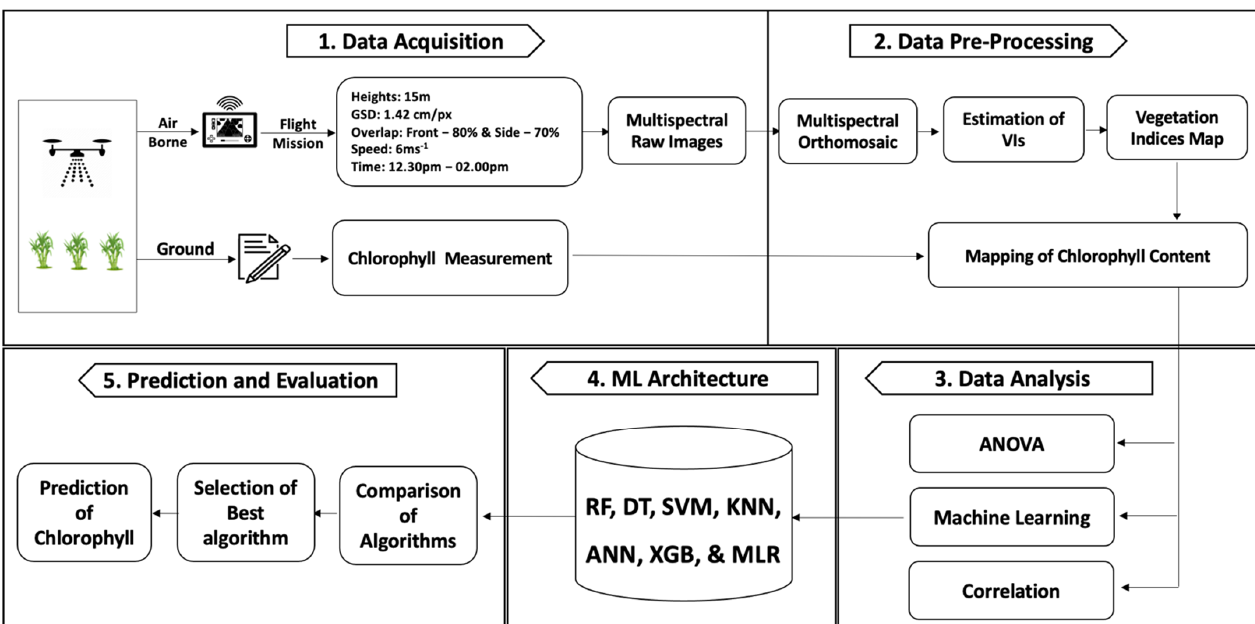
Figure 3. Primary pipeline for prediction of chlorophyll content in the sugarcane field.